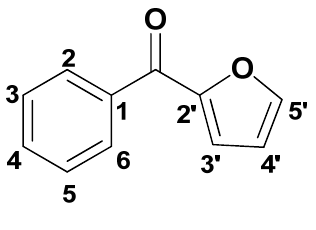
Table 1. Structures of the target new